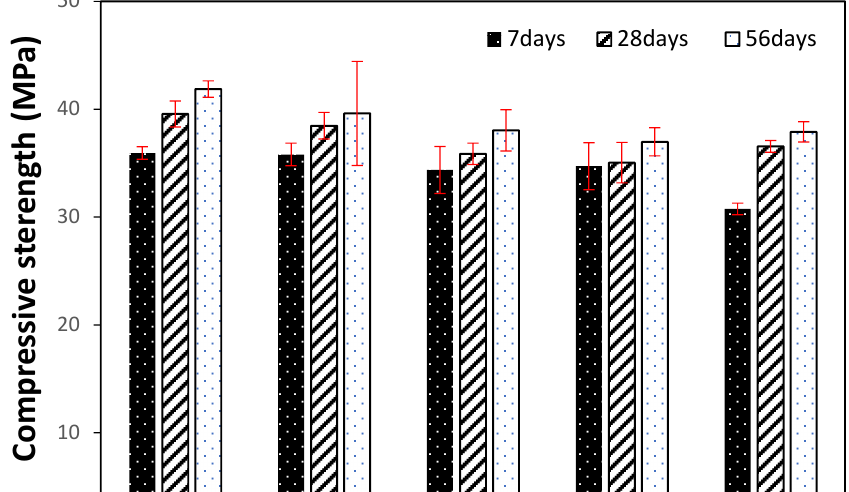
Figure 4. Mortar flow.